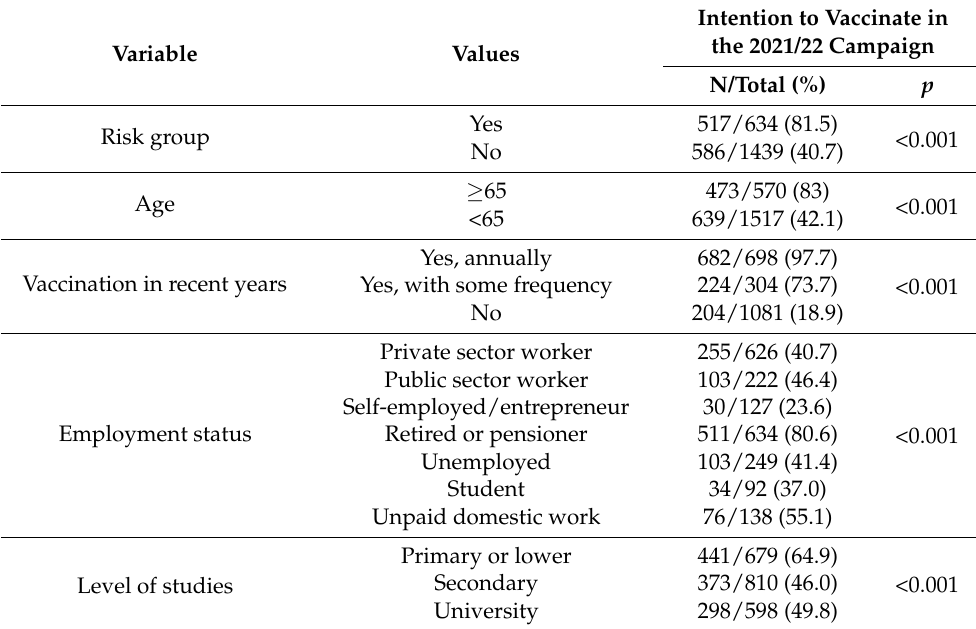
Table 4. Attitudes and practices regarding intention to get vaccinated against flu in the 2021/22 campaign during the COVID-19